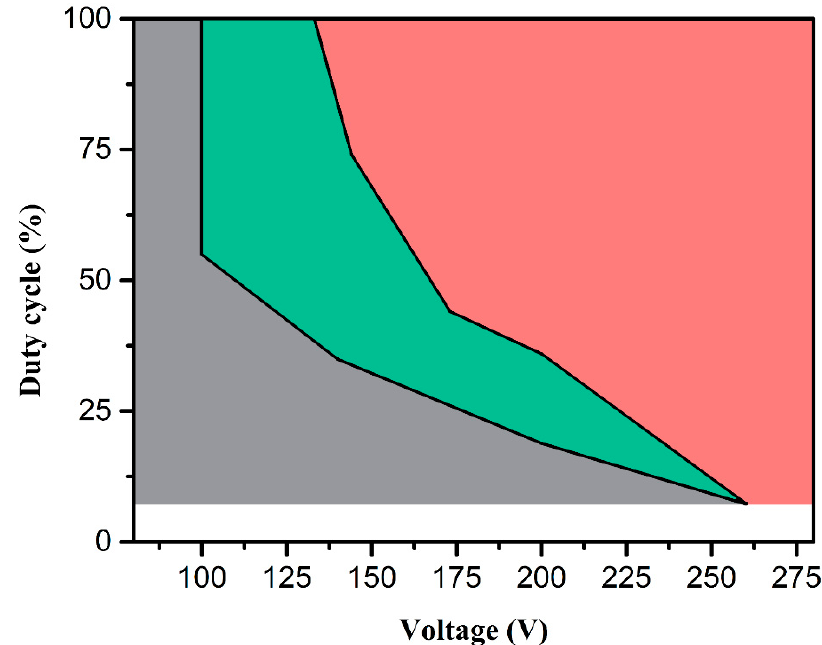
Figure 2. Suitable parameters of pulsed current power source at frequency of 4000 Hz for liquid electrolysis plasma formation.